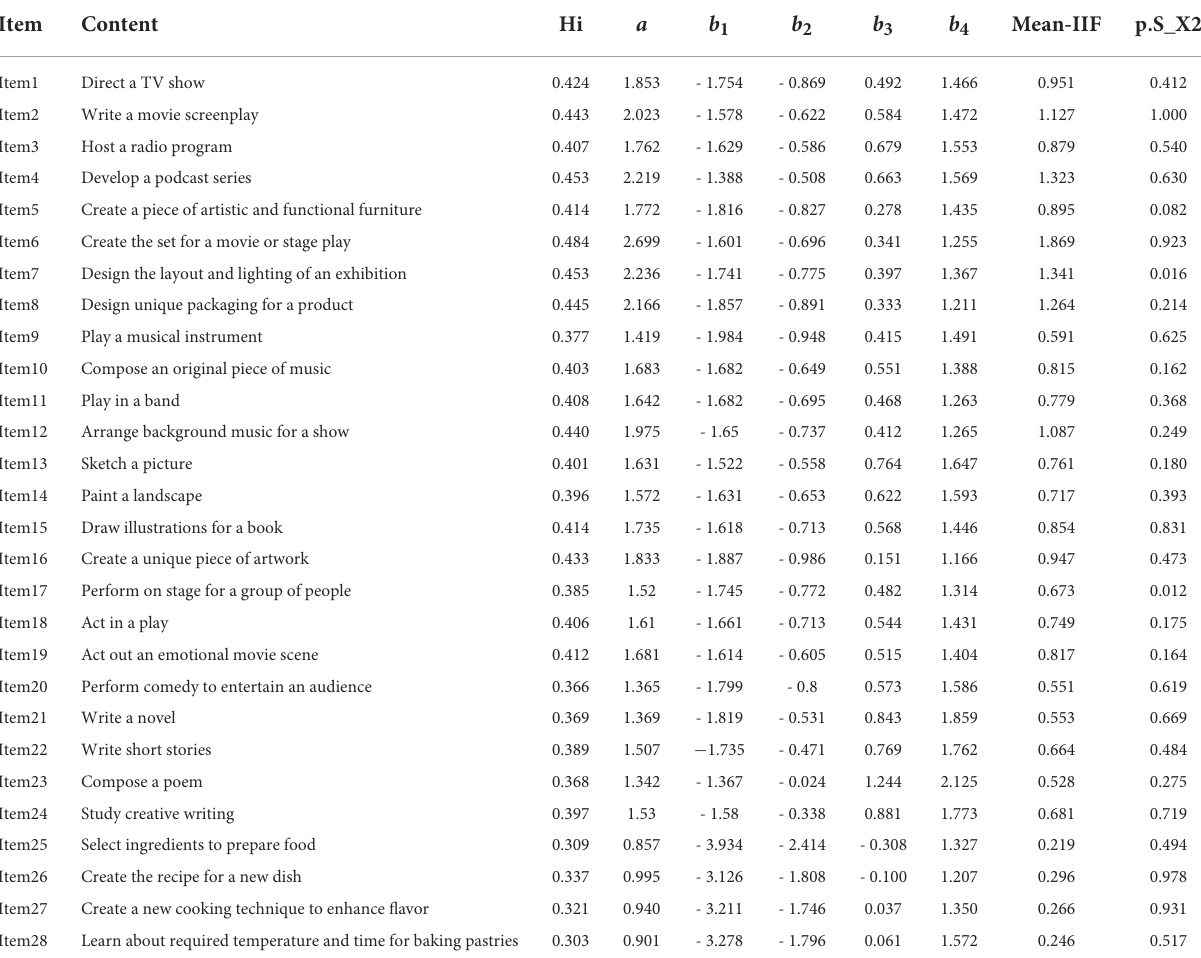
TABLE 3 Graded response model (GRM)’s item